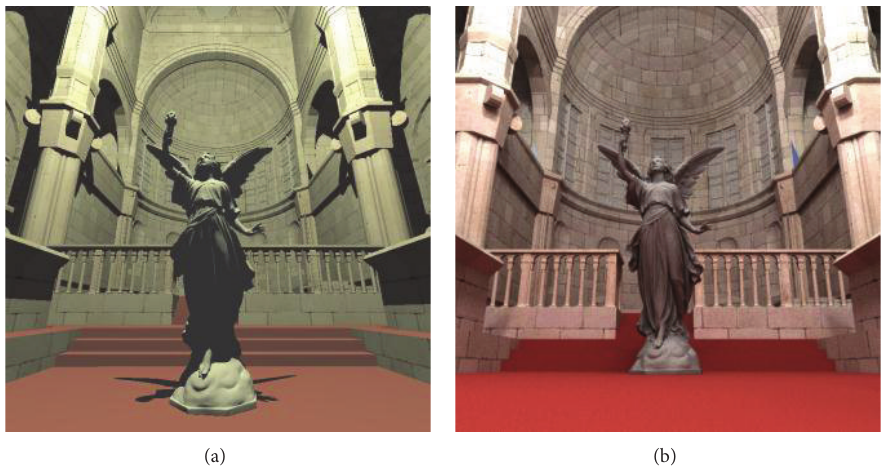
Figure 4: Ray tracing versus path tracing. (a) was rendered using the Arauna ray tracer [9], which supports direct illumination from point lights only. (b) uses path tracing for direct and indirect illumination of area light sources.